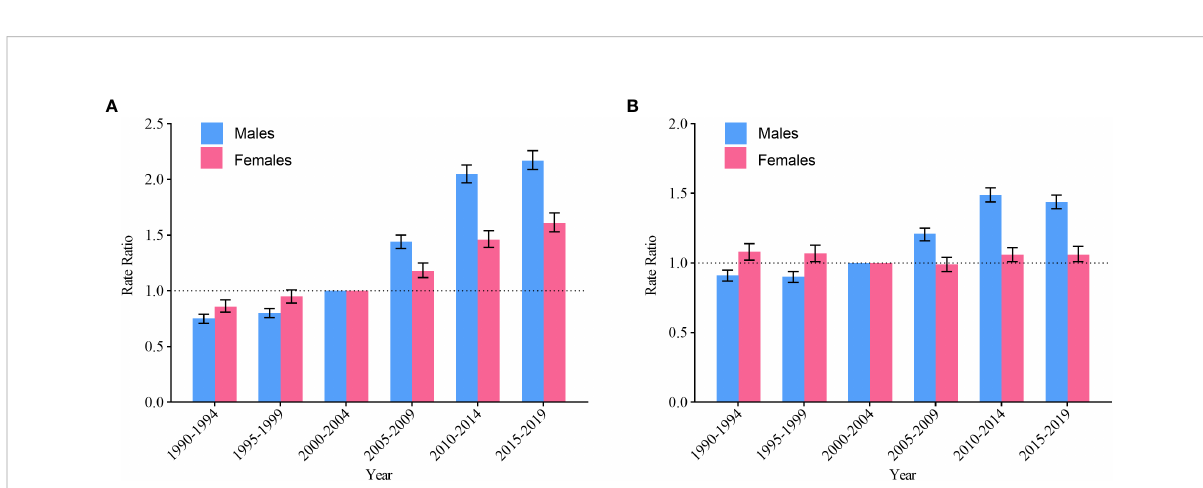
FIGURE 5 Period RR of non-Hodgkin lymphoma by gender in China. (A) incidence; (B) mortality.